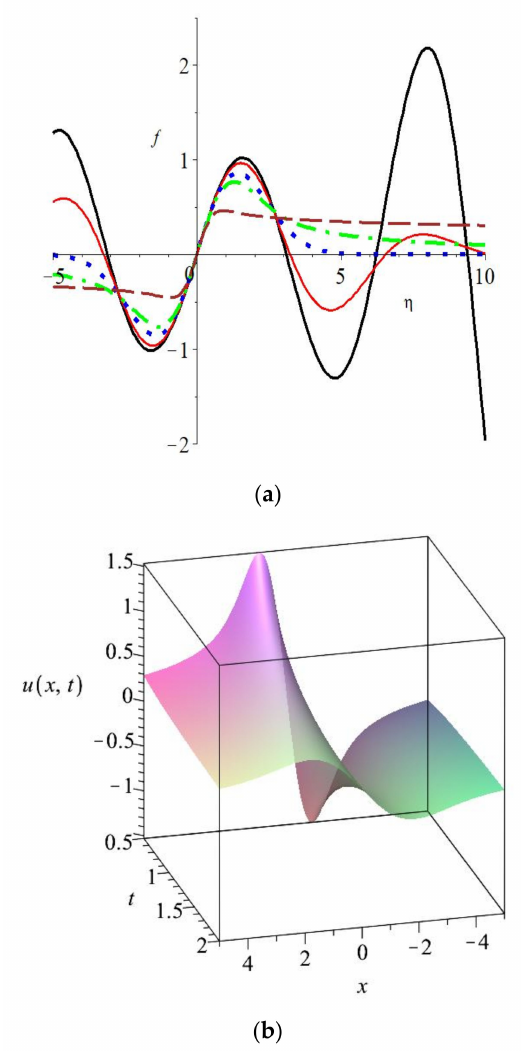
Figure 10. The M part of the solutions in the case of time-dependent diffusion coefficients of Equation (25). ( a ) Shape functions for different n exponents of the diffusion parameter. The black, red, blue dotted, green dashed-dotted, and brown dashed lines are for n = − 1.1, − 0.8, 0, 1, and 10, respectively. ( b ) Illustration of the solution given in Equation (28) for ˆ α =